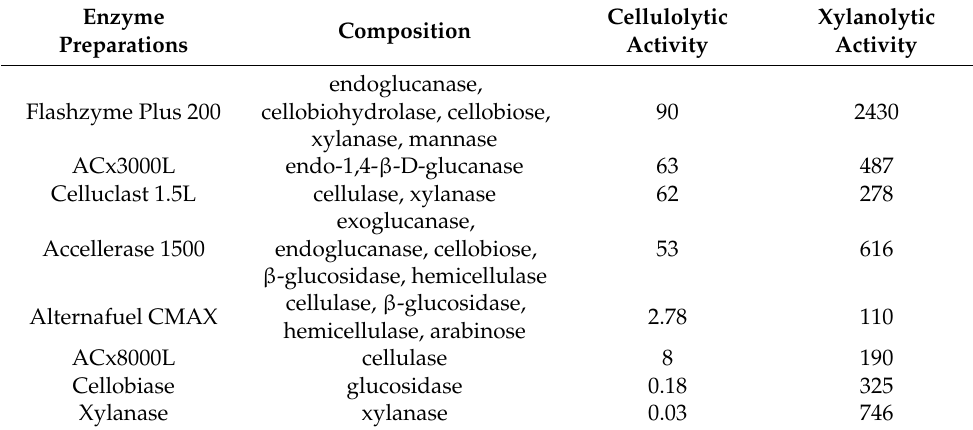
Table 4. The determination of cellulolytic and xylanolytic activities of commercial enzyme prepara- tions (FPU · mL − 1